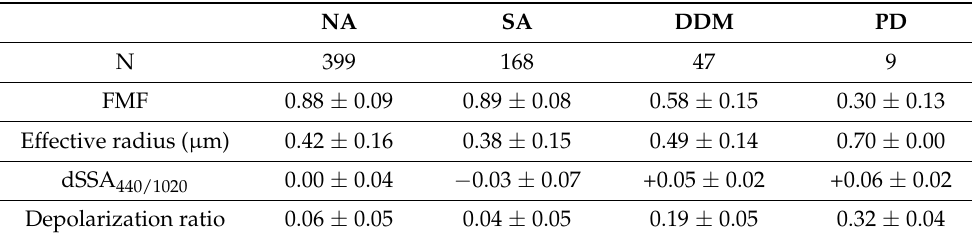
Table 2. Average values of AERONET-derived aerosol properties classified by the RF